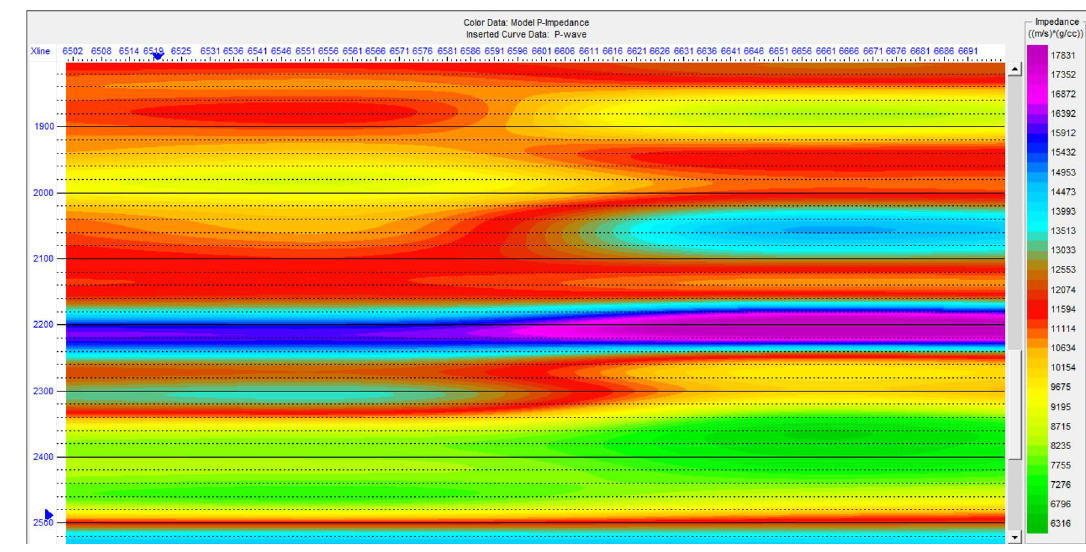
Fig. 10 Initial model of acoustic impedance based on the interpreted horizons and well log information